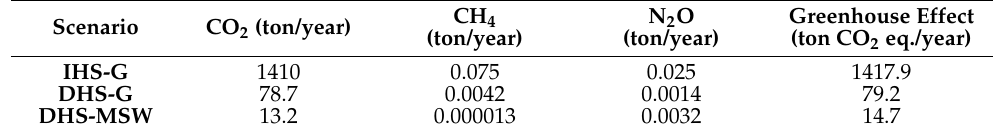
Table 18. The GHG emission and the greenhouse effect of the three